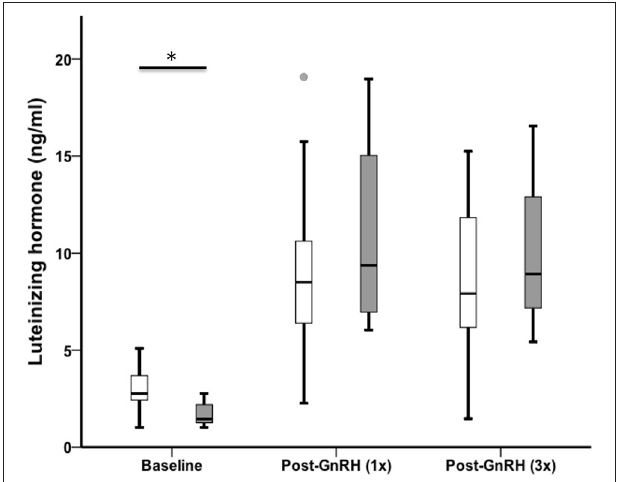
FIGURE 2 | Male sedentary urban juncos (white boxes) had higher baseline levels of LH than male migrant juncos (gray boxes). LH increased in both groups 5 min after a GnRH-challenge and remained high after two additional injections timed 30min apart (* p ≤ 0.05). The groups did not differ in LH from one another post-GnRH injections. Boxes represent upper quartile, median, and lower quartile. Whiskers include the range of values except for outliers. Outliers include values > 1.5 box lengths